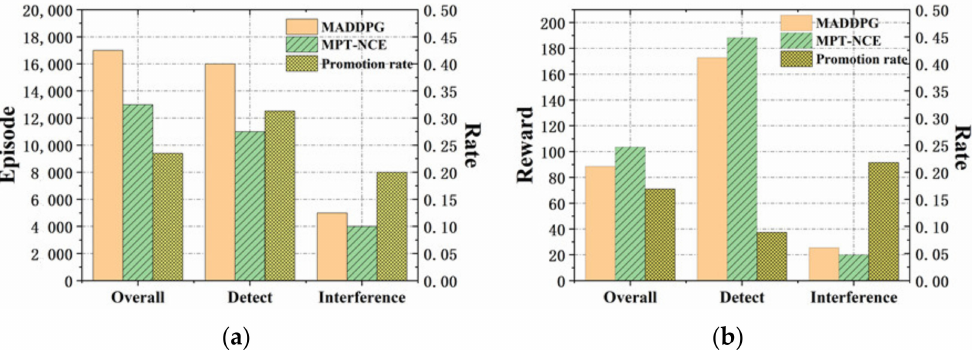
Figure 6. Performance comparison chart of prediction experiment: ( a ) shows a comparison chart of training times and ( b ) shows a comparison chart of the reward function